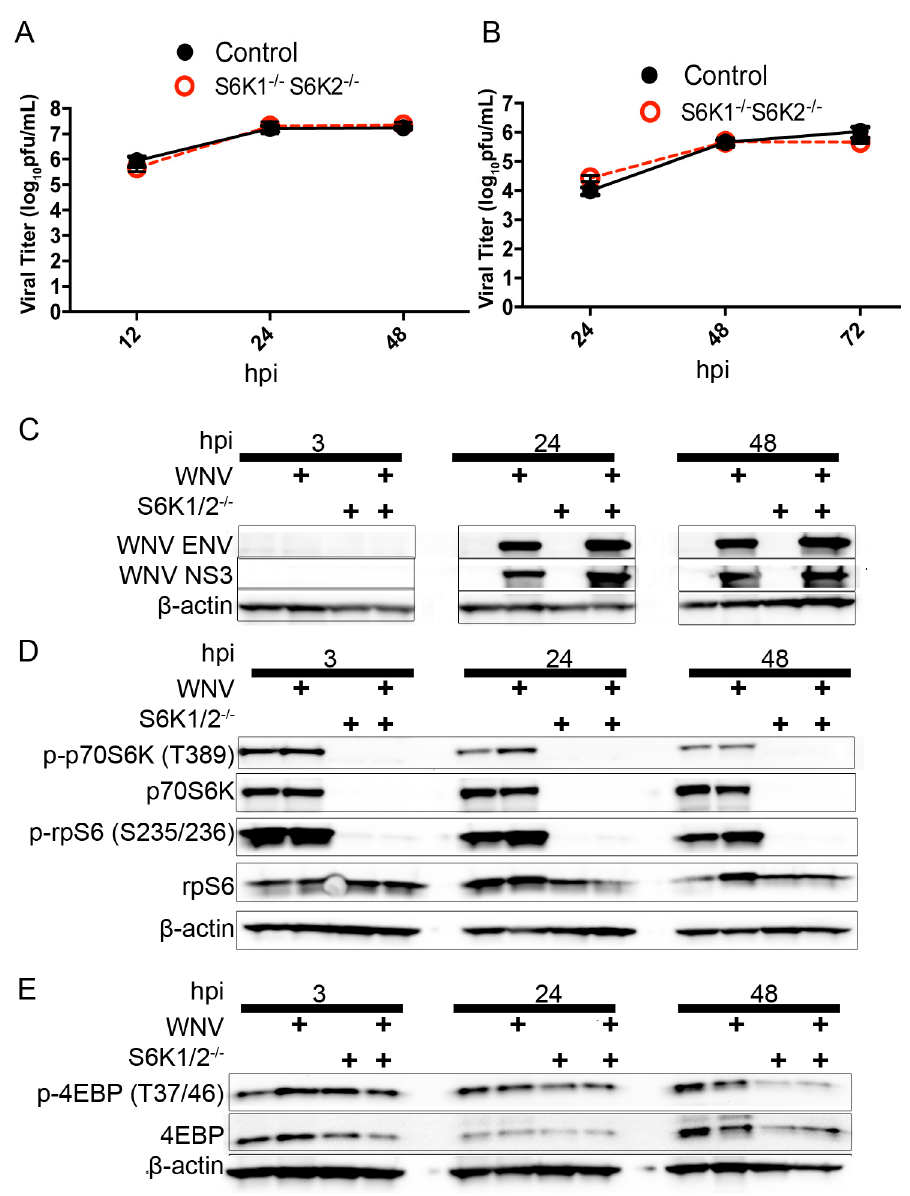
Figure 5. P70S6K activity does not support WNV growth or protein expression. ( A ) Single-step growth curve of WNV (MOI = 3) in S6K1/2 − / − and wild-type control MEFs; ( B ) Multi-step growth curve (MOI = 0.001) of WNV in S6K1/2 − / − and wild-type control MEFs. Supernatants were harvested at the indicated hpi for standard plaque assay. N = 6 replicates per time point; ( C ) WB analysis of mock- and WNV-infected (MOI = 3) S6K1/2 − / − and wild-type cells for WNV protein expression. Cellular lysates were collected at the indicated hpi and probed using antibodies for WNV ENV, WNV NS3, and β -actin loading control. Representative of 2 independent experiments; ( D ) WB analysis of mock- and WNV-infected (MOI = 3) S6K1/2 − / − and wild-type cells for rpS6 and p70S6K expression and phosphorylation. Cellular lysates were collected at the indicated hpi and probed using antibodies against p-p70S6K [T389], total p70S6K, p-rpS6 [S235/236], total rpS6, and β -actin loading control. Representative of two independent experiments; ( E ) WB analysis of mock- and WNV-infected (MOI = 3) S6K1/2 − / − and wild-type cells for 4EBP expression and phosphorylation. Cellular lysates were collected at the indicated hpi and probed using antibodies for p-4EBP [T37/46], total 4EBP, and β -actin loading control. Representative of two independent experiments.